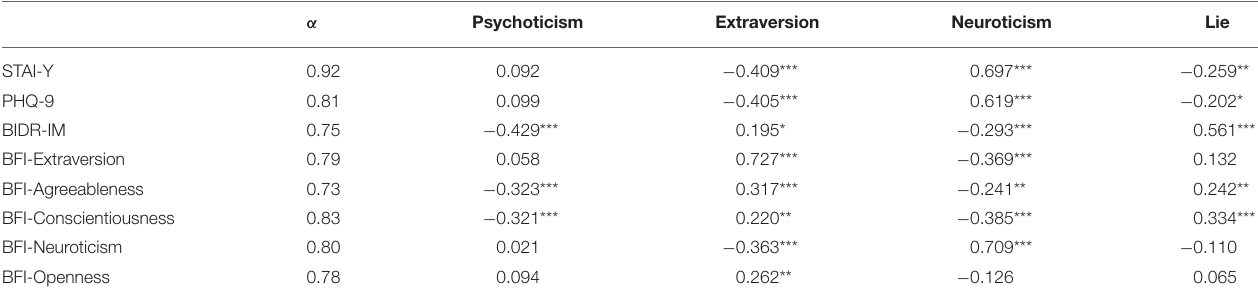
TABLE 5 | Cronbach’s α s and correlations between the four PEN-L traits, STAI-Y, PHQ-9, BIDR-IM, and the five BFI dimensions.